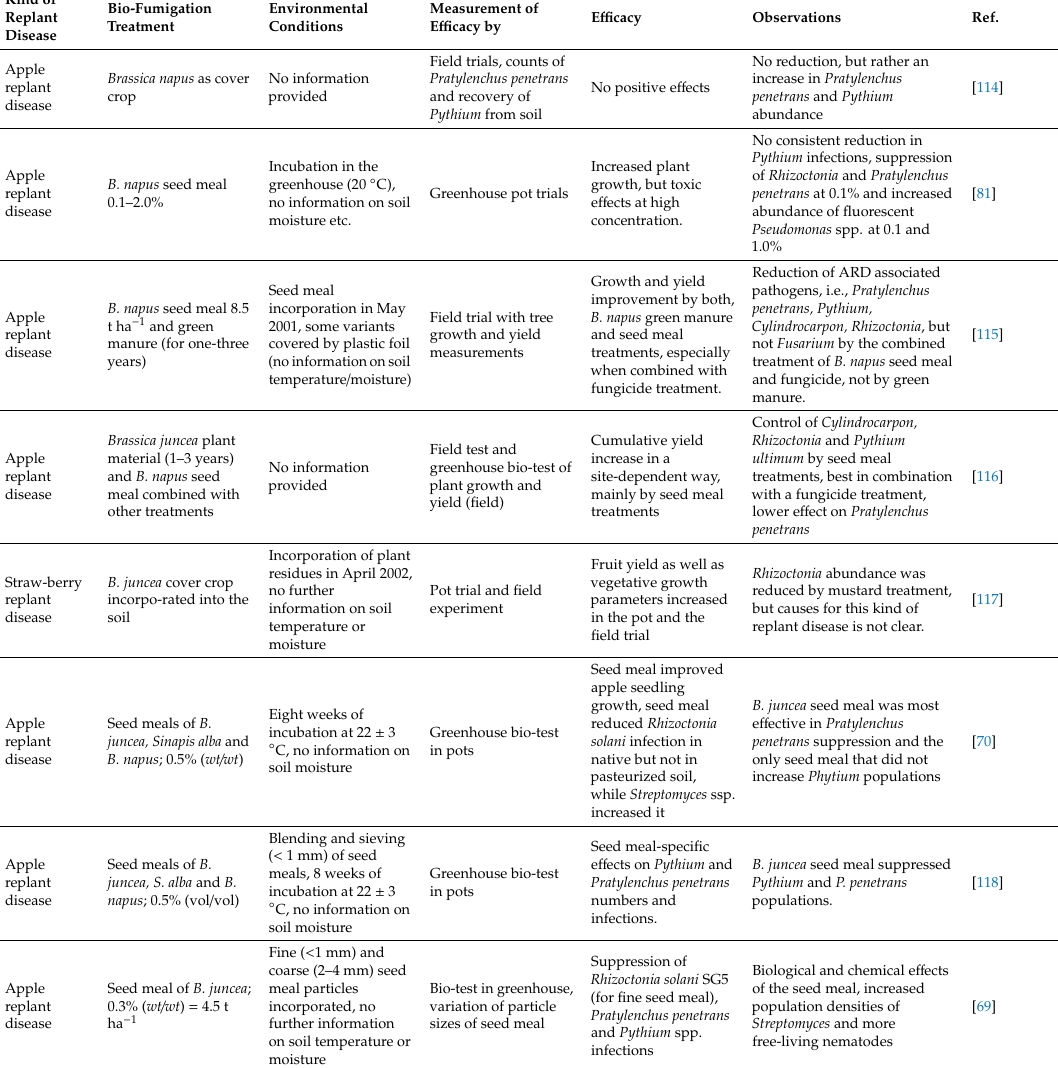
Table 1. Overview of studies using biofumigation as counteraction of replant disease. Ref.-Reference. Kindof